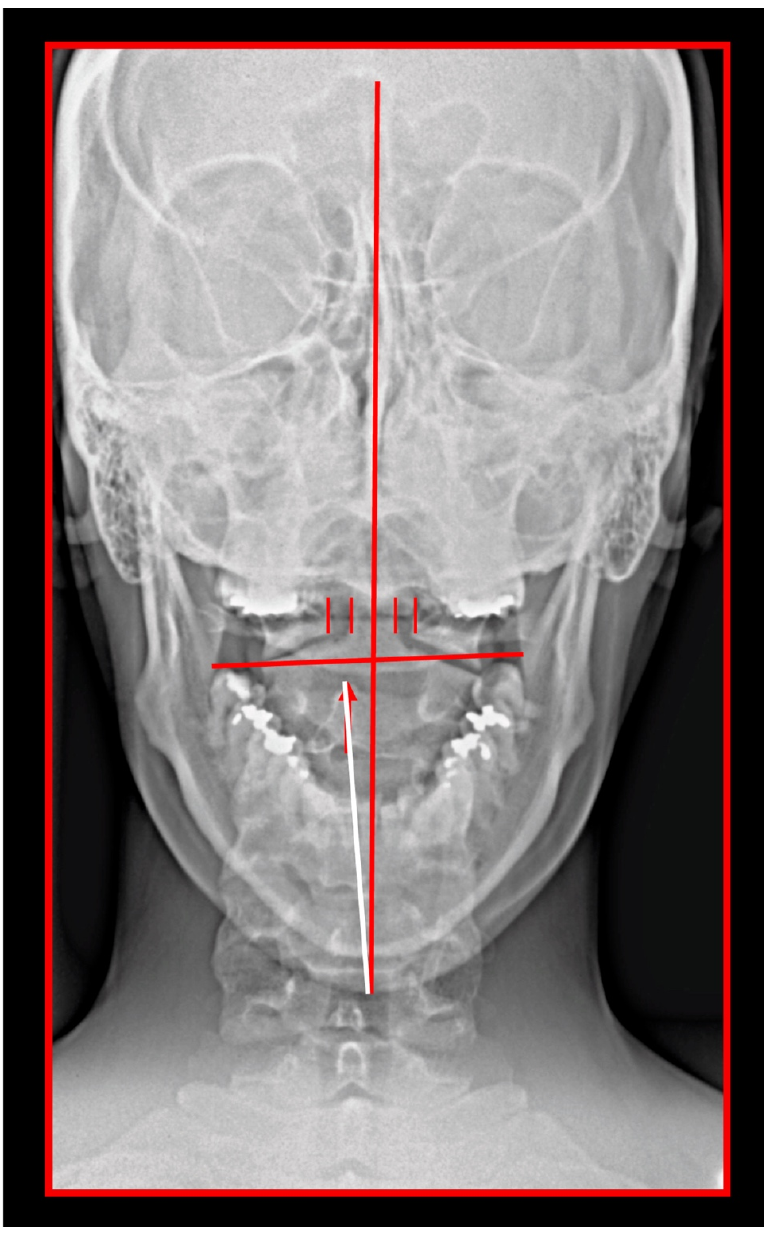
Figure 4. Transoral atlas - axis X-ray. Skeletal midline— dens axis —spinous process of C 2 should be in one single line. In this patient, spinous process of axis is deviated to the right; hence, the axis is rotated to the left. The position of the atlas is measured from the lateral mass of the atlas to the dens axis . The space is increased on the right; hence, the atlas is rotated to the right. The mandibular occlusal plane is inclined. The cranium is rotated to the left; the left eye pupil is lower than the right.